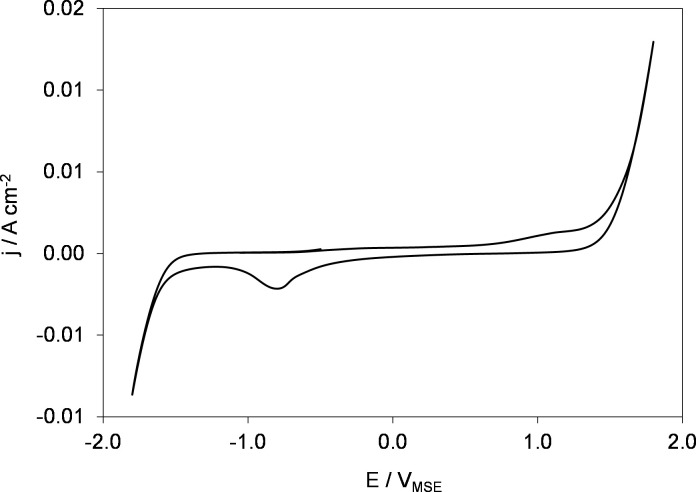
Cyclic voltammogram of GC electrode in 0.5 M H2SO4 solution.Scan rate, sr: 100 mV s–1. Temperature, T = 295 K.